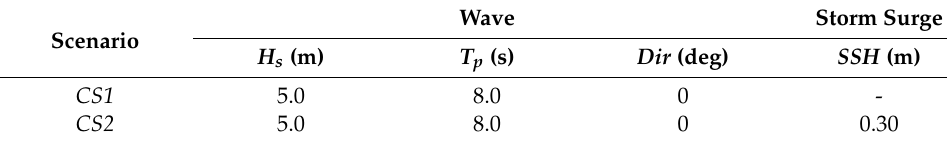
Table 4. Scenarios used for the applications for coastal structures design evaluation.